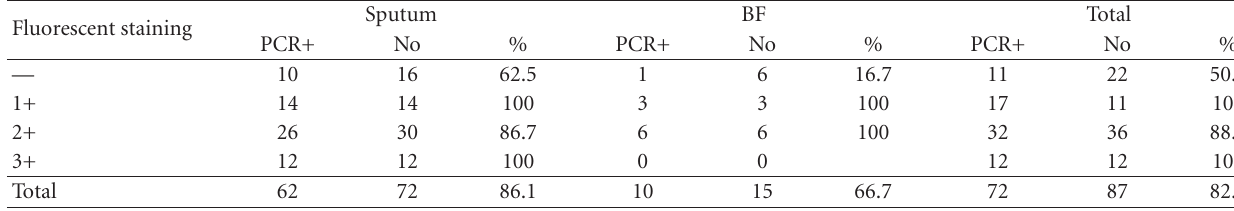
Table 3: M. intracellulare PCR positivity rates according to fluorescent staining from Apr 2007 to Mar 2011. Fluorescent staining